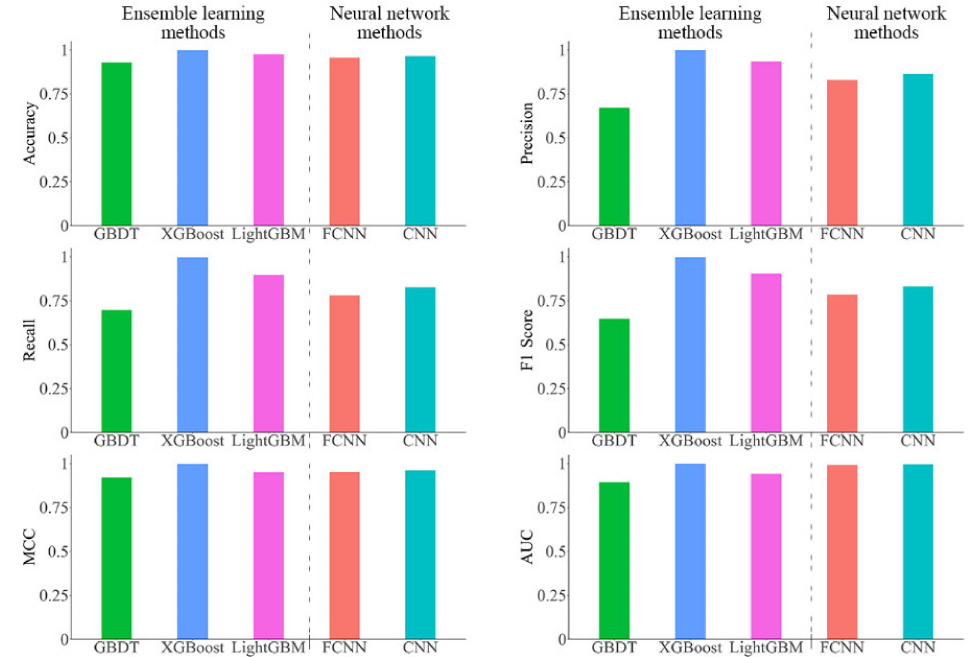
Figure 5. The comparison of accuracy, precision, recall, F1 score, Matthews Correlation Coefficient (MCC) and Area Under the receiver operating characteristic Curve (AUC) of proposed and original methods based on ensemble learning and neural network models on the actual UAV